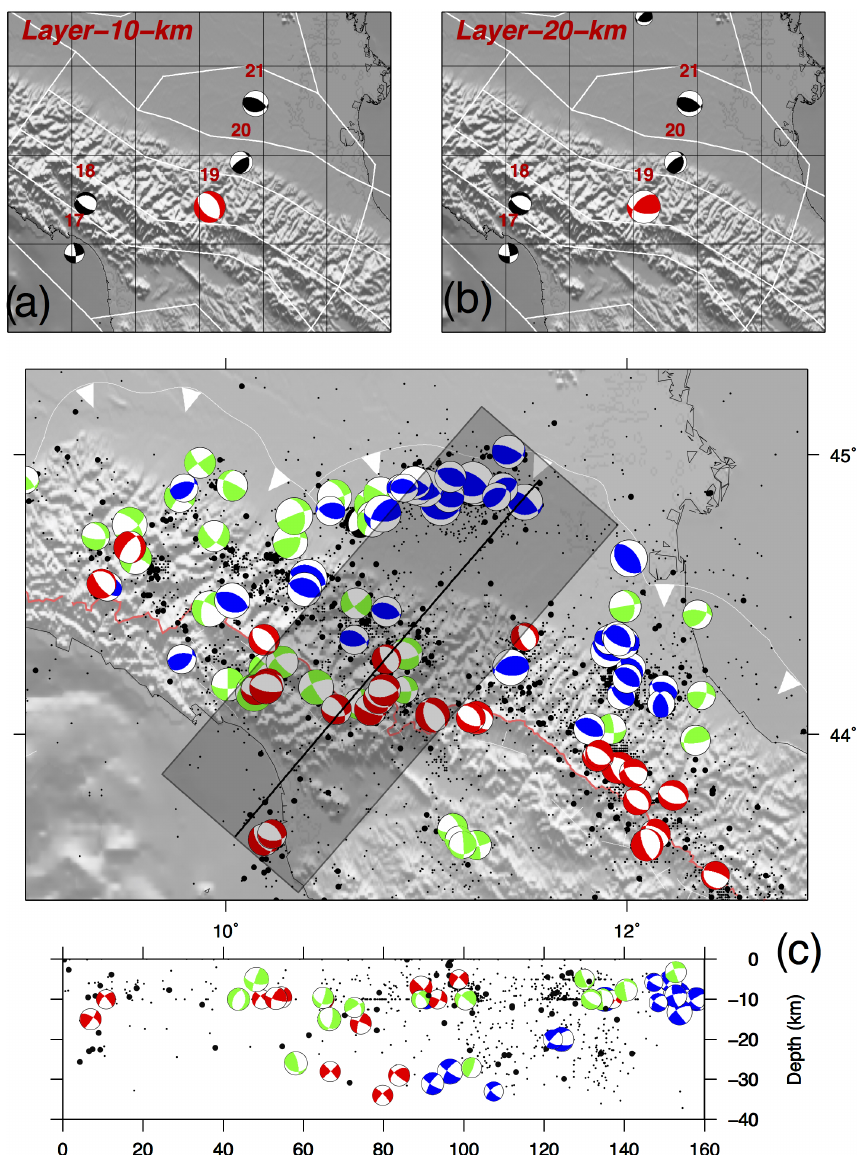
Figure 3. (a, b) An example of tectonic style layering for seismic zone no. 19. The cumulative moment tensor obtained for 10km of thickness shows a completely different result with respect to the one given by 20km. Red numbers indicate the seismic zones. (c) Map and section of our dataset in the region of seismic zone no. 19; red, green, and blue focal mechanisms are respectively normal, strike-slip, and reverse. Seismicity in the background (black dots, smaller for events with M < 3) is from the ISIDe Working Group (2007).